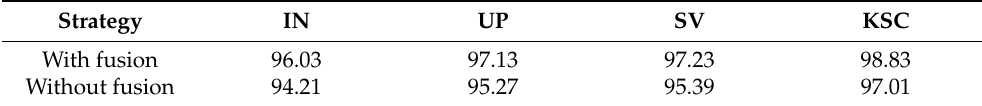
Table 10. Effective analysis of the feature fusion strategy